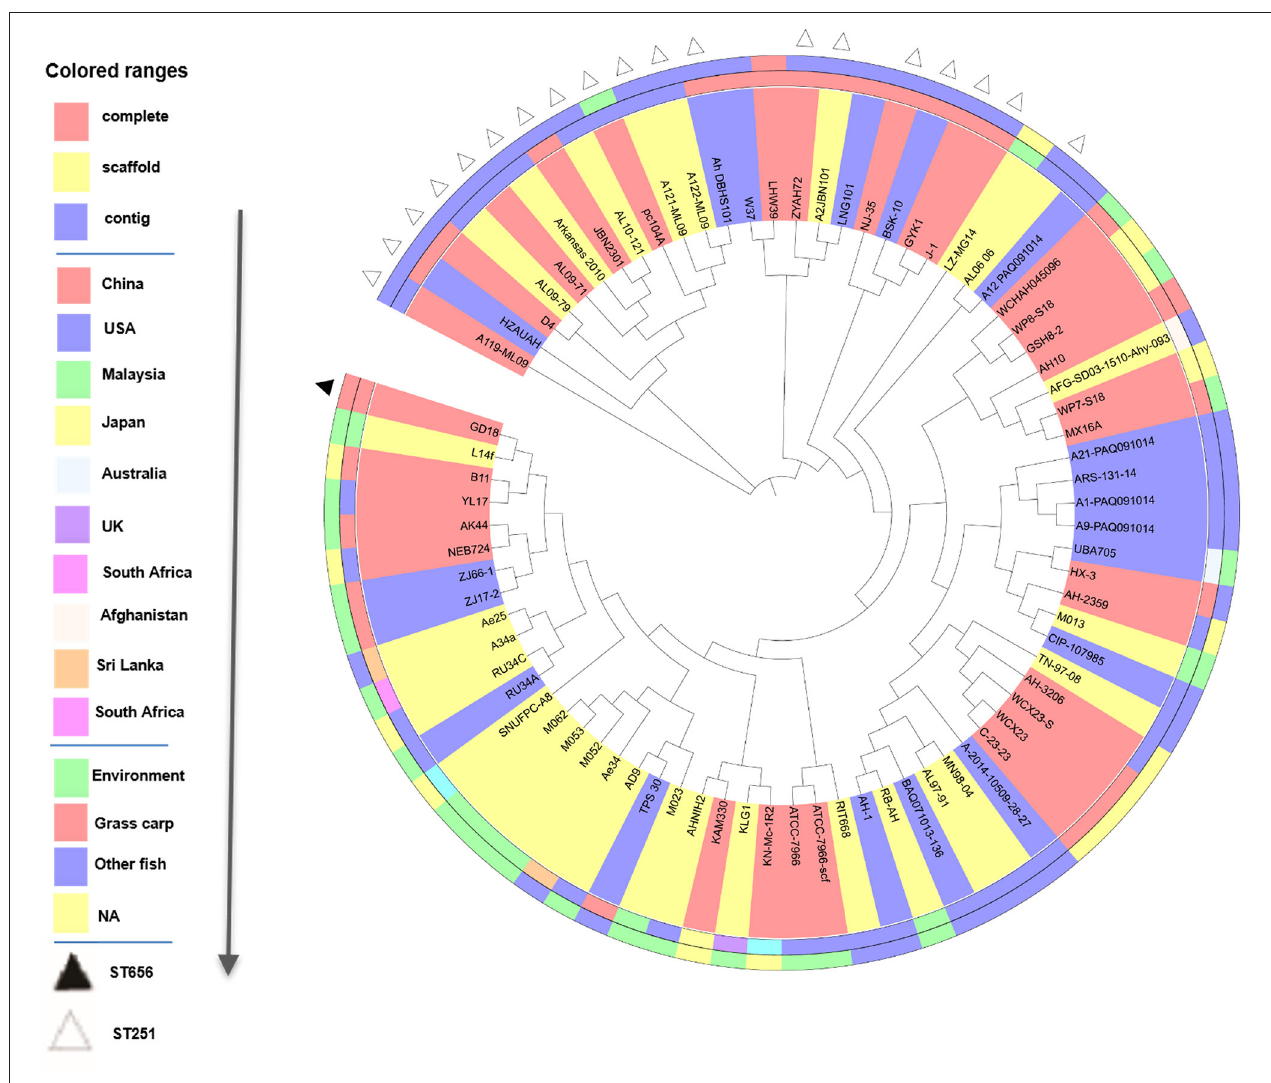
FIGURE 4 | Phylogenetic tree analysis of 78 A. hydrophila strains. Phylogenetic tree based on the 1246 core genes of the 78 A. hydrophila isolates. Sequencing type, isolation country, and source of A. hydrophila strains are color-coded in the following rings. On the outermost ring, STs are distinguished by